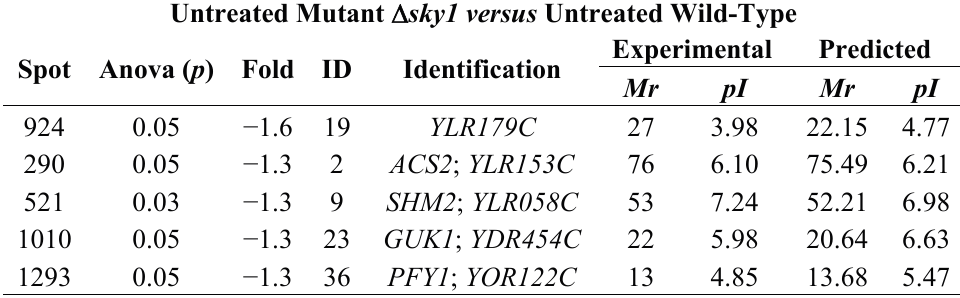
Table 1. Proteins with significant abundance changes in the proteome analyses. Untreated Mutant  sky1 versus Untreated Wild-Type Experimental Spot Identification